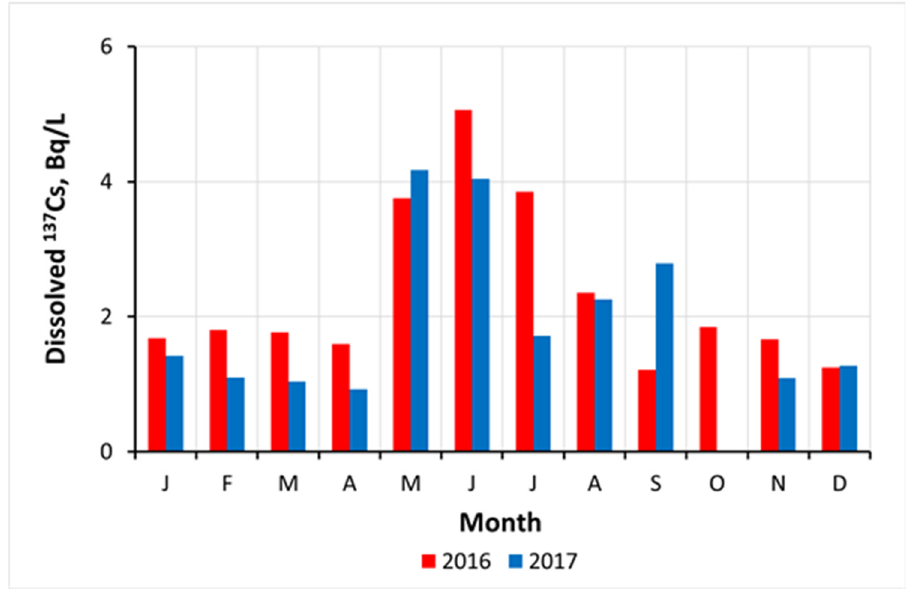
Figure 10. Seasonal variations of dissolved 137 Cs activity concentration in water of Suzuuchi irrigation pond in Okuma town at FDNPP exclusion zone in 2016 and 2017 [53].